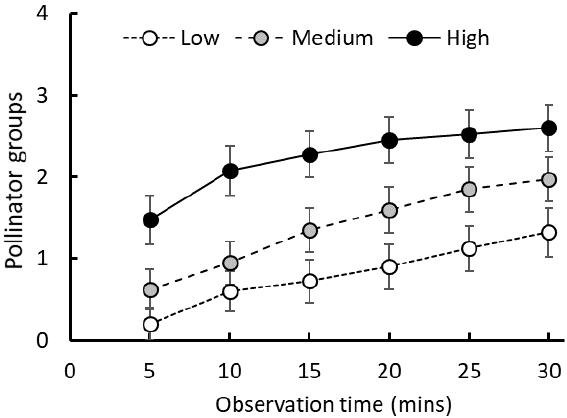
Figure 3. Number of pollinator groups ( Bombus spp., Apis mellifera , solitary bees, syrphids) recorded in observation periods extending from 5 to 30 minutes in 2 x 2 m plots having low, medium, and high flower density (mean ± 95% CI; n =